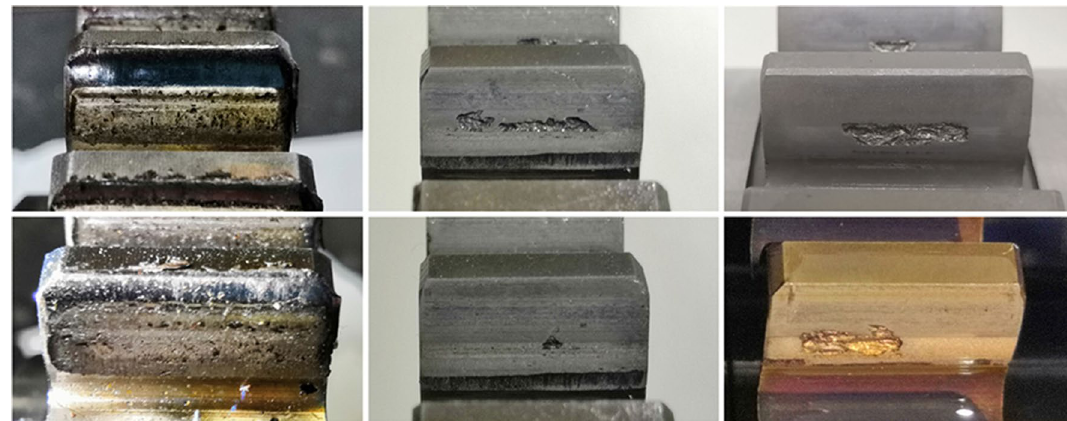
Figure 8 Partial presentation of the gear pitting dataset